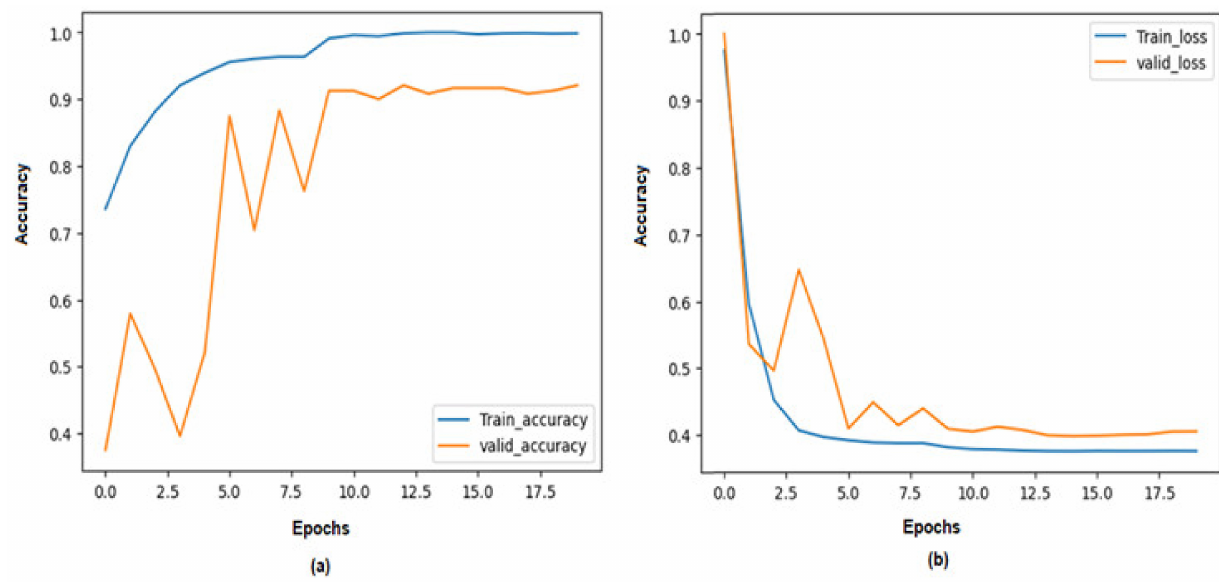
Figure 10. Performance of MobileNet. ( a ) Accuracy; ( b ) loss.